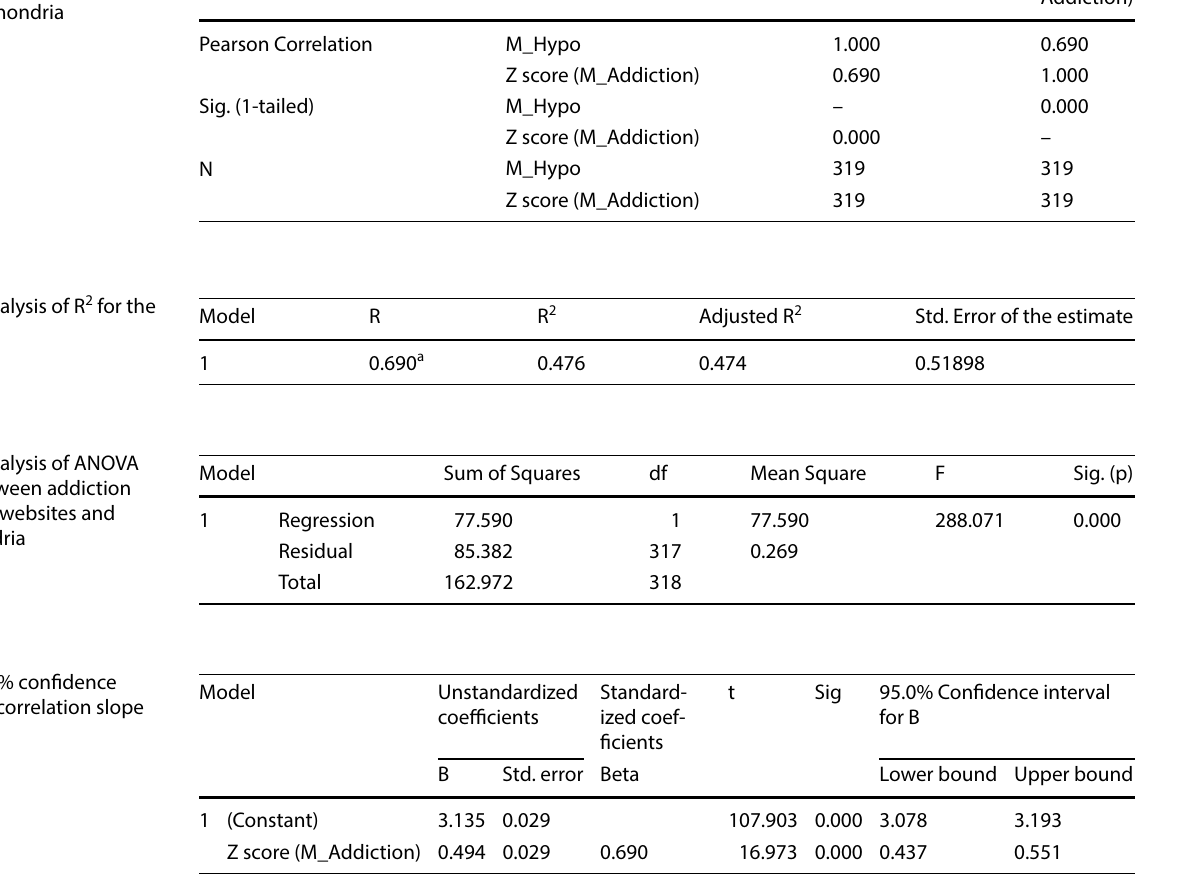
Fig. 1 Scatter plot between hypochondria and addiction to medical websites Table 2 Correlation between addiction to medical websites